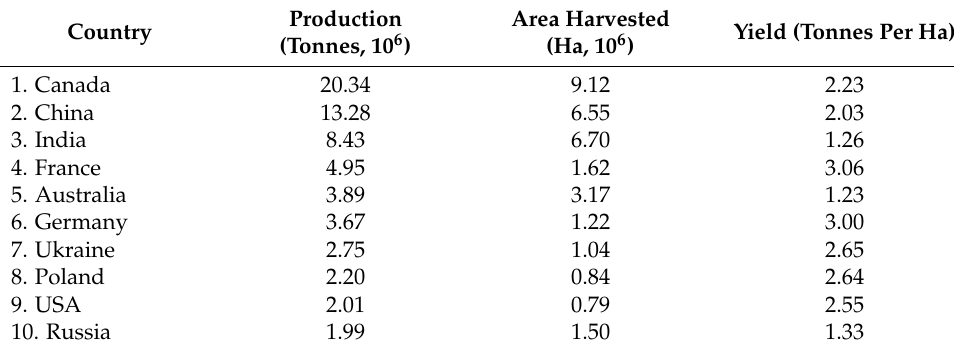
Table 1. The top 10 producing countries for canola with corresponding area harvested and yield in 2018 [10]. Production Area Harvested Yield (Tonnes Per Country (Tonnes, 10 6 ) (Ha, 10 6 )